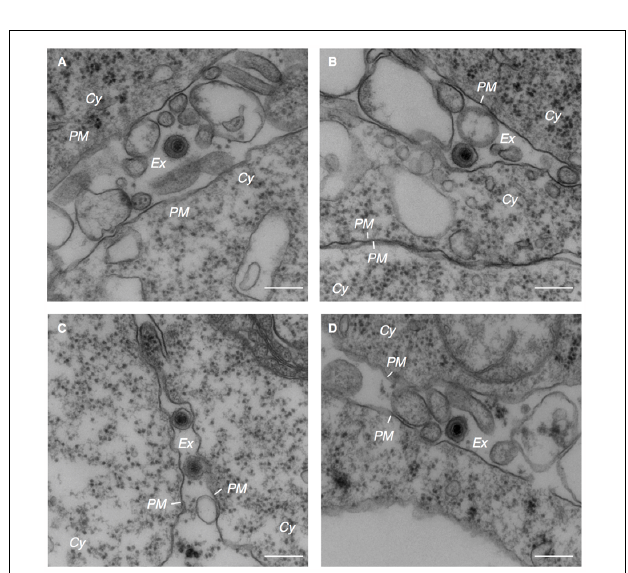
FIGURE 3 | EBV capsids acquire final envelopes in the cytoplasmic compartments. Morphological features of Akata − eGFP-EBV cells induced into lytic cycle showing acquisition of secondary envelope of EBV. Akata − eGFP-EBV cells were treated with α hIgG for 24 h. High power views of Akata − eGFP-EBV cells (A–D) . The white arrowheads indicate high electron-dense material. The white arrows indicate the clathrin-coated vesicles. Scale bars: 250 nm.